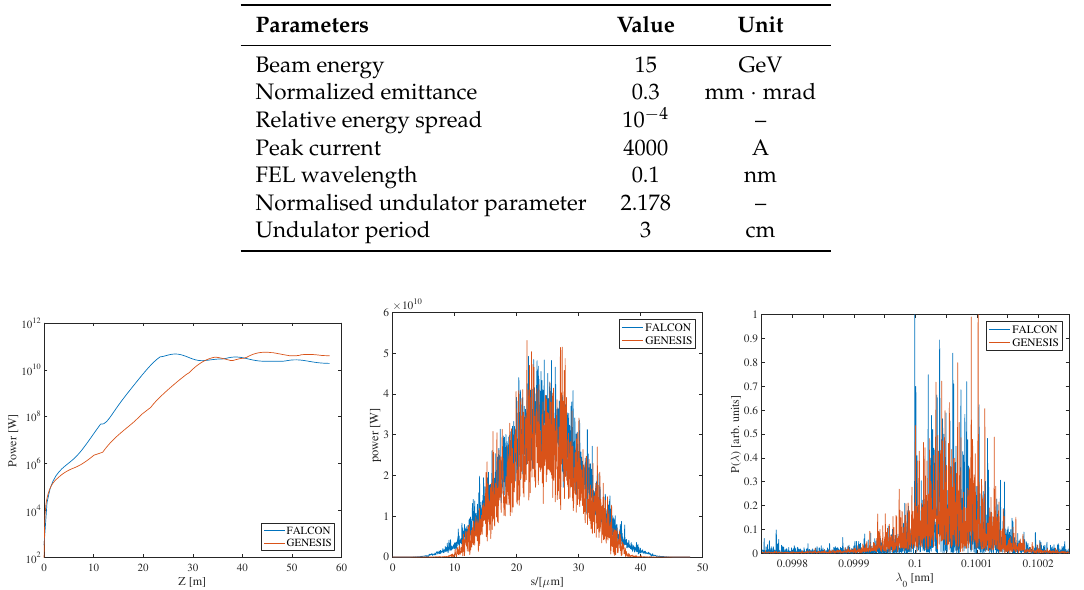
Table 1. Simulation Parameters for the self-amplified spontaneous emission (SASE).